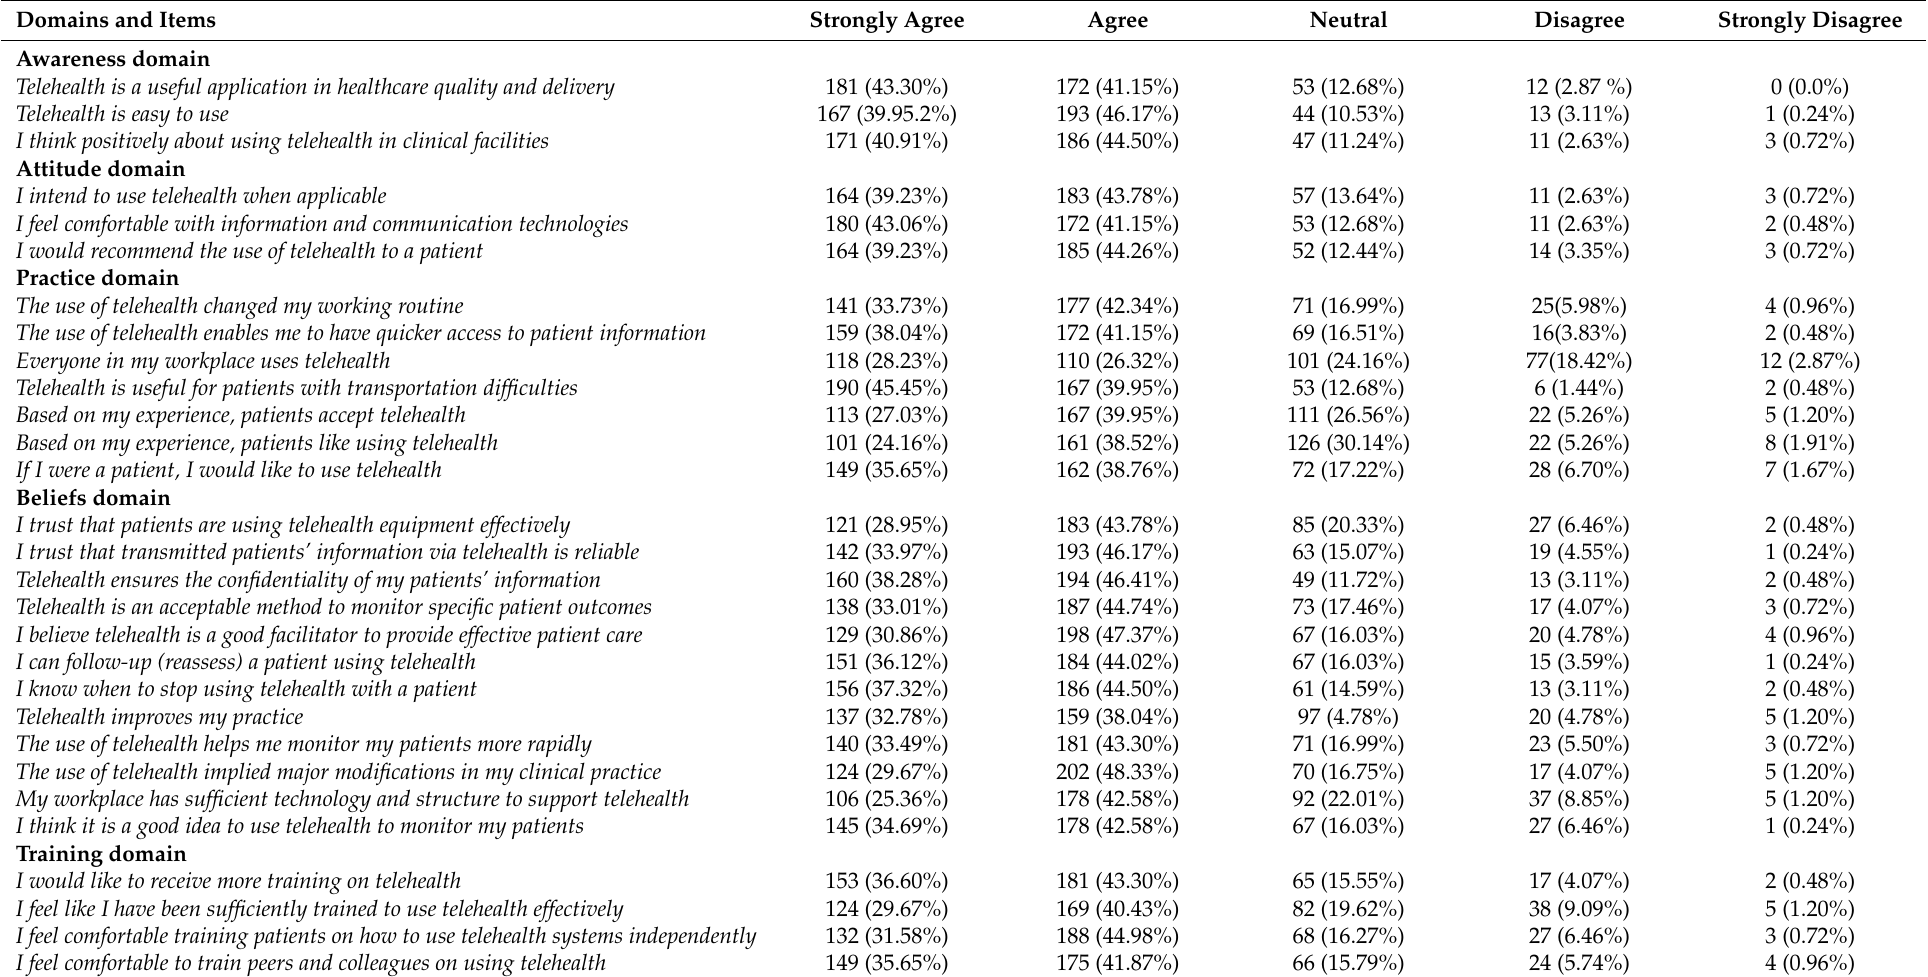
Table 2. Perception of Telehealth Applications among Users ( n =